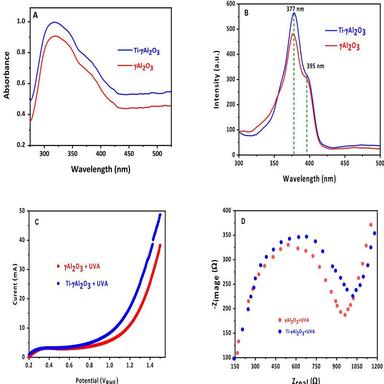
A) UV–Vis absorption spectra, B) Photoluminescence spectra (excitation = 280 nm), C) EIS spectra, and D) photocurrent density of ɣAl2O3 and Ti-ɣAl2O3.